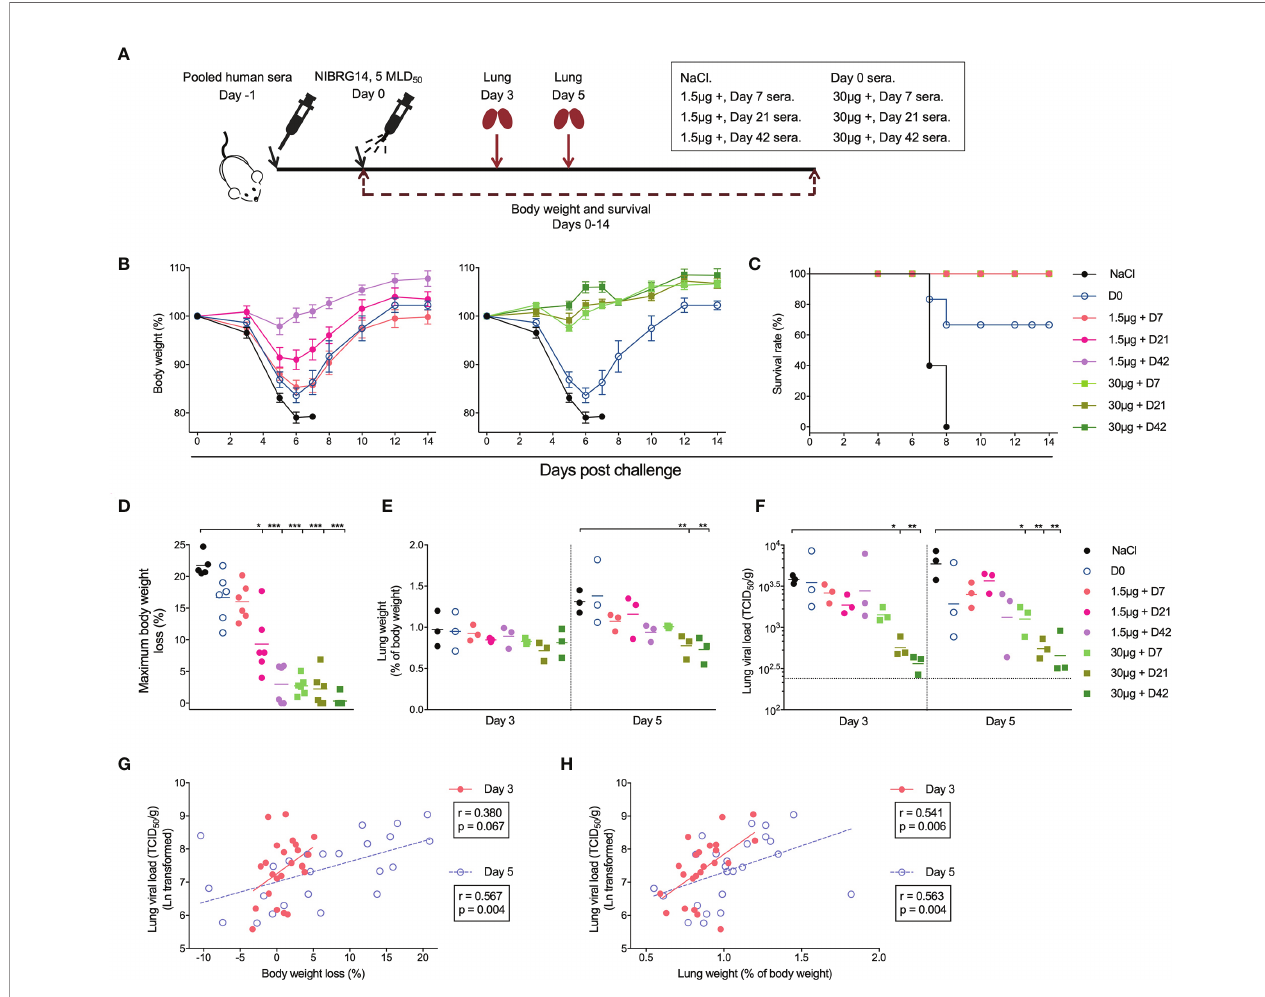
FIGURE 4 | Adjuvanted H5N1 vaccines elicit antibodies provided in vivo protection against lethal virus challenge. (A) Illustration of the experiment set-up for serum transfer and virus challenge. Pre-vaccination sera from subjects in 1.5 m g + and 30 m g + groups were pooled together as D0 sera. Sera from days 7, 21 and 42 after vaccination from subjects in 1.5 m g + or 30 m g + groups were pooled separately. Group-and time-point-wise pooled sera were administered intraperitoneally to female BALB/c mice (n=12 per group). NaCl was given as control. One day later, the mice were infected intranasally with 5× 50% mice lethal dose (MLD50) of NIBRG-14 virus. Body weight and survival were monitored for 14 days after challenge. Lungs from 3 mice per group were collected 3 and 5 days after infection for weight and viral load measurement. (B, C) The body weight loss (B) and survival rate (C) of the mice in different groups are shown. (D) Maximum body weight loss was calculated for each individual mouse as the maximum body weight loss through 14 days monitoring, which occurred at 5, 6 or 7 days after challenge. For mice with no body weight loss observed through monitoring, maximum weight loss was assigned as 0,01%. (E, F) The lung weight of the 3 mice sacri fi ced on days 3 and 5 after virus challenge was measured and is shown as the mean of percentage of pre-infection body weight (% of body weight, E ). The viral load of NIBRG-14 virus was measured in MDCK cells as the reciprocal dilutions of lung homogenates that gave 50% tissue culture infection dose (TCID50) and standardized based on the lung weight (TCID50/g, F ). The dotted line indicates the lowest detectable viral load in the assay. (G, H) The standardized lung viral load (TCID50/g) 3 and 5 days after infection correlate with the body weight loss (G) and the lung weight (H) . The body weight of mice in each group is shown as mean ± standard deviation as error bar (B) . Means (D, E) and geometric means (F) are shown as horizontal lines, and each symbol represents one mouse (D – H) . *P < 0.05, **P < 0.01, ***P < 0.001 (lung viral load was Ln transformed in statistical analyses. False Discovery Rate controlled multiple comparisons between mice receiving NaCl and pooled sera were performed in Nonparametric Kruskal-Wallis test in D – F ). The standardized lung viral load was Ln transformed in statistical analyses. Linear fi tting curve is plotted as solid line (Day 3) or dotted line (Day 5) when nonparametric Spearman P < 0.10. Spearman r and P values are noted for each correlation (G, H) . Duplicates were performed in lung weight and viral load